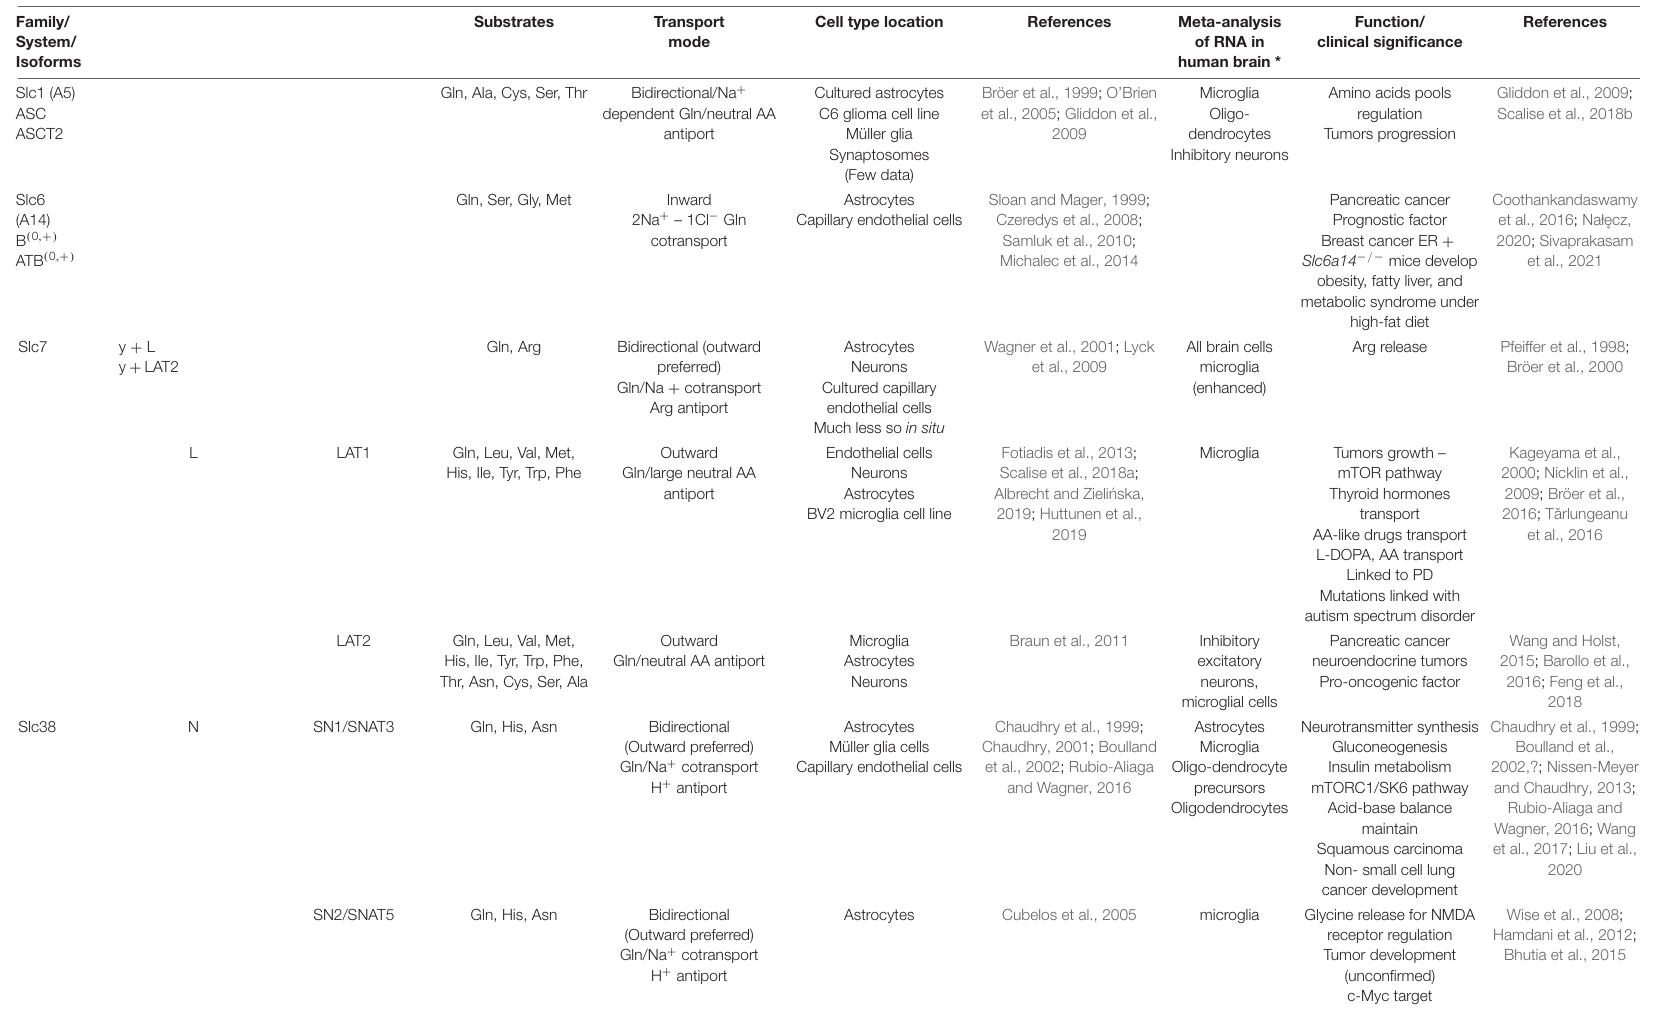
TABLE 1 | Classification and characteristics of astrocytic glutamine transporters. Family/